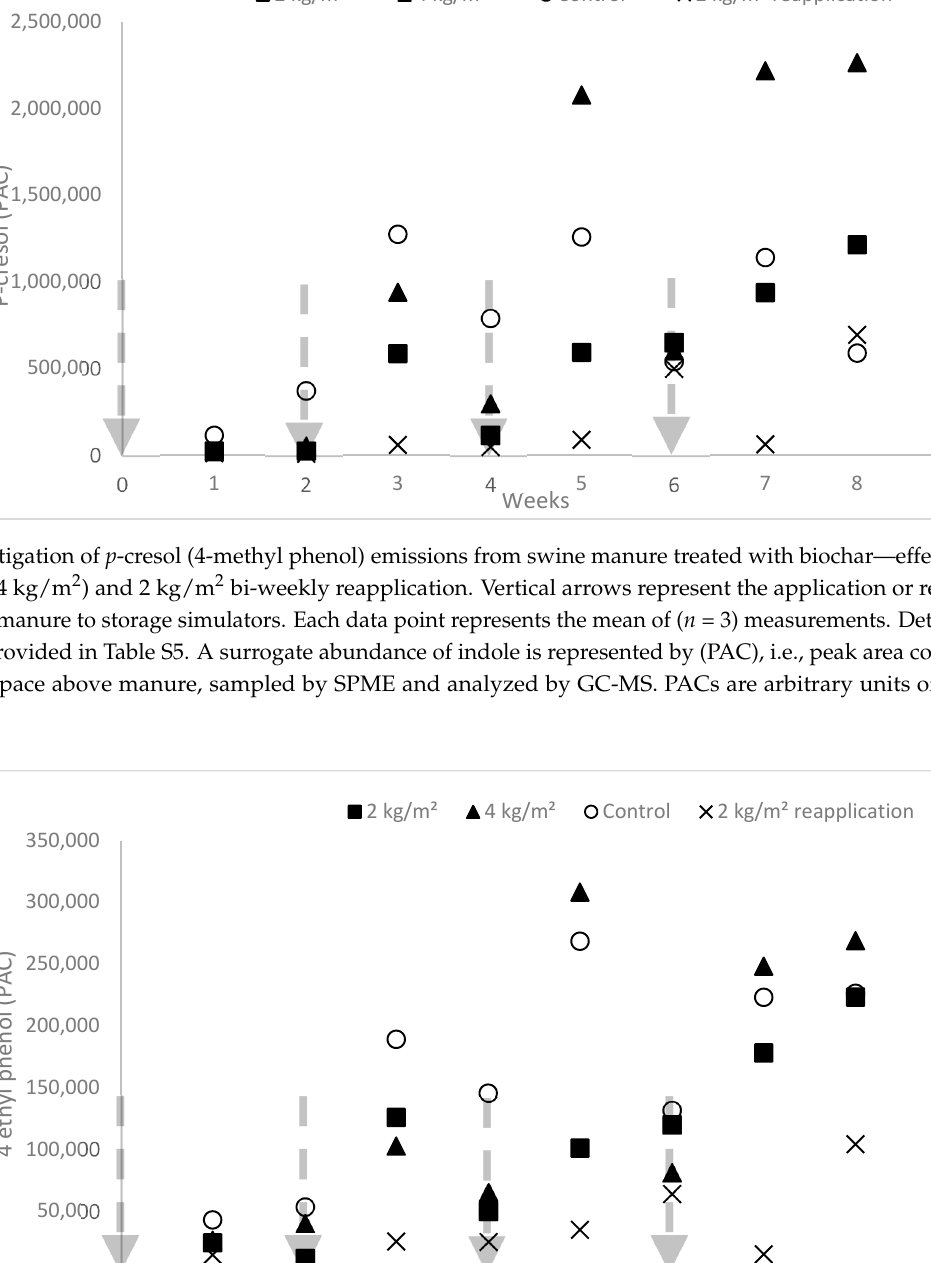
Figure 4. Mitigation of phenol emissions from swine manure treated with biochar—effects of one-time dose (2 and 4 kg/m 2 ) and 2 kg/m 2 bi-weekly reapplication. Vertical arrows represent the application or reapplication of biochar and manure to storage simulators. Each data point represents the mean of ( n = 3) measurements. Detailed statistical analysis is provided in Table S4. A surrogate abundance of indole is represented by (PAC), i.e., peak area counts for indole in the headspace above manure measured by SPME and analyzed by GC-MS. PACs are arbitrary units of M.S. detector response.